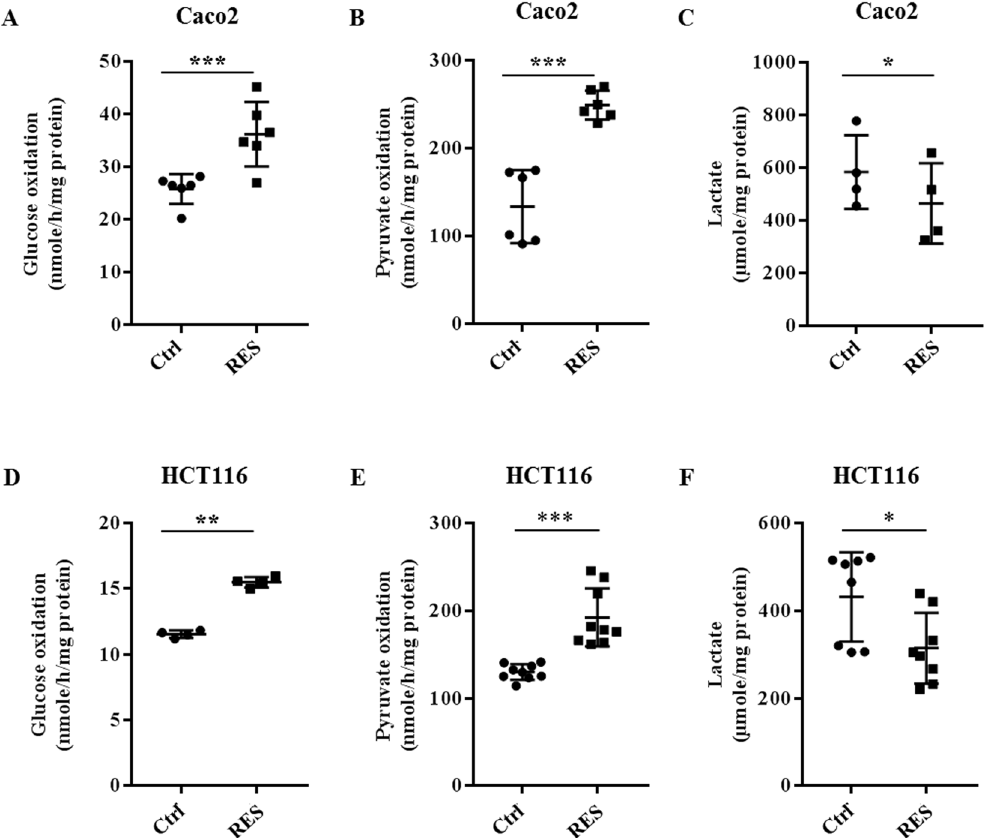
Figure 2. Resveratrol induces a shift toward oxidative metabolism in colon cancer cells. After treatment with 10 µ M resveratrol (RES) for 48 hr, oxidative capacity was evaluated as following: subconfluent cancer cells were isolated and 10 6 cells were incubated in Krebs-Ringer phosphate buffer supplemented with 5 mM [U 14 C]- glucose (isotopic dilution 1/1000) ( A , D ) or with 5 mM 14 C 1 -pyruvate (isotopic dilution 1/250) ( B , E ). 14 CO 2 was recovered as described in the Material and Methods section. The lactate secretion in the medium was measured under the same conditions ( C , F ) as described in the Material and Methods section. ( * p < 0,05, ** p < 0,01, *** p < 0.001 vs control).